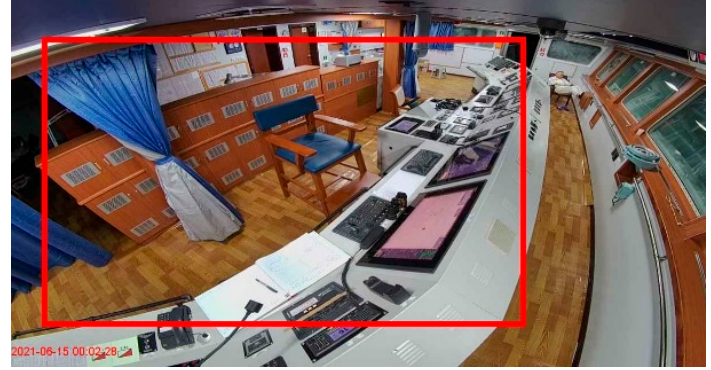
Figure 1. Real-time monitoring of leaving one’s post.